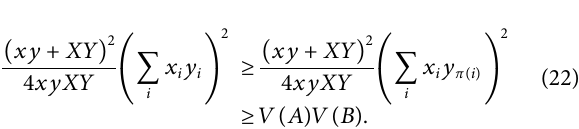
FIGURE 2 | Lower bounds of V ( A ) + V ( B ) for a family of spin-1 particles | Ψ ( θ ) 〉 : the sum-form uncertainty relation V ( A ) + V ( B ), our bound L 2 of Eq. 20 , andtheboundofRef.[34]aredepictedinblue,green,andyellowrespectively.